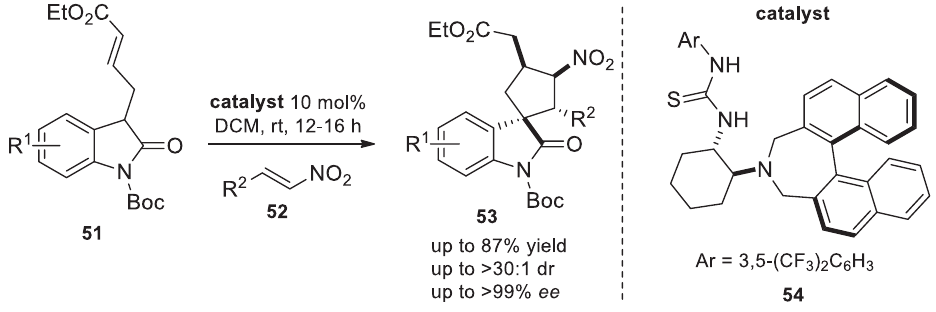
Figure 13 . Thiourea catalysed enantioselective synthesis, from Ref.